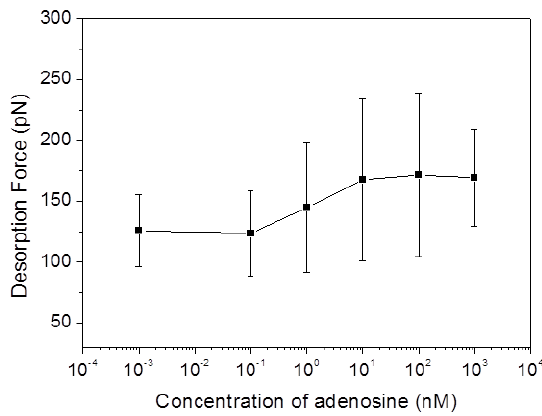
Figure 5. Mean desorption forces from SMFS experiments conducted in binding buffer with different concentrations of adenosine (1 pM, 100 pM, 1 nM, 10 nM, 100 nM, and 1 μM).